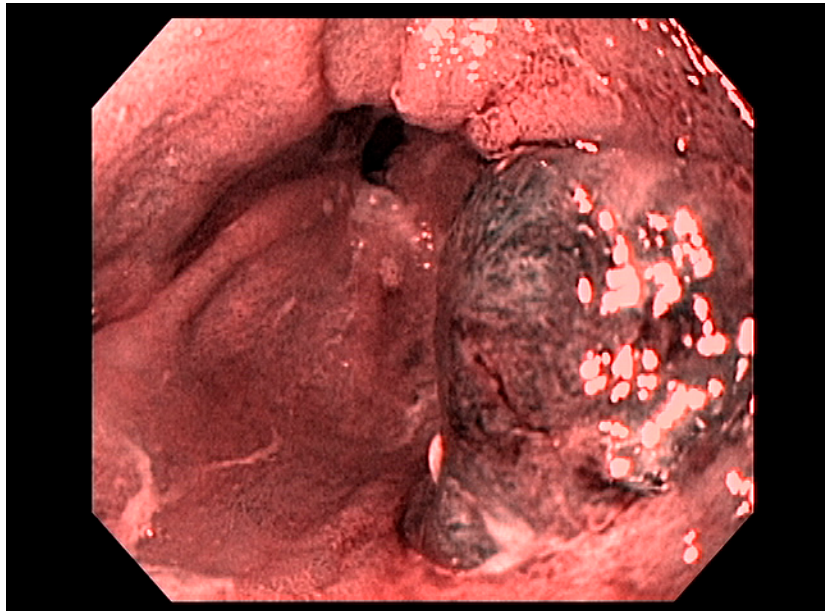
Figure 3. T1a esophageal cancer in Barrett’s Esophagus.